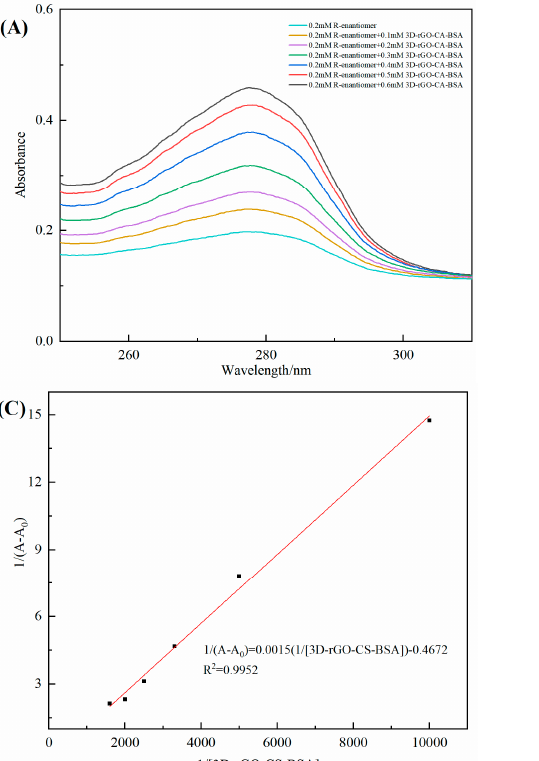
Figure 8. Water contact angles of ( A ) 3D–rGO–CS, ( B ) 3D–rGO–CS–BSA, ( C ) 3D–rGO–CS–BSA+S–enantiomer, and ( D ) 3D–rGO–CS–BSA+R–enantiomer.